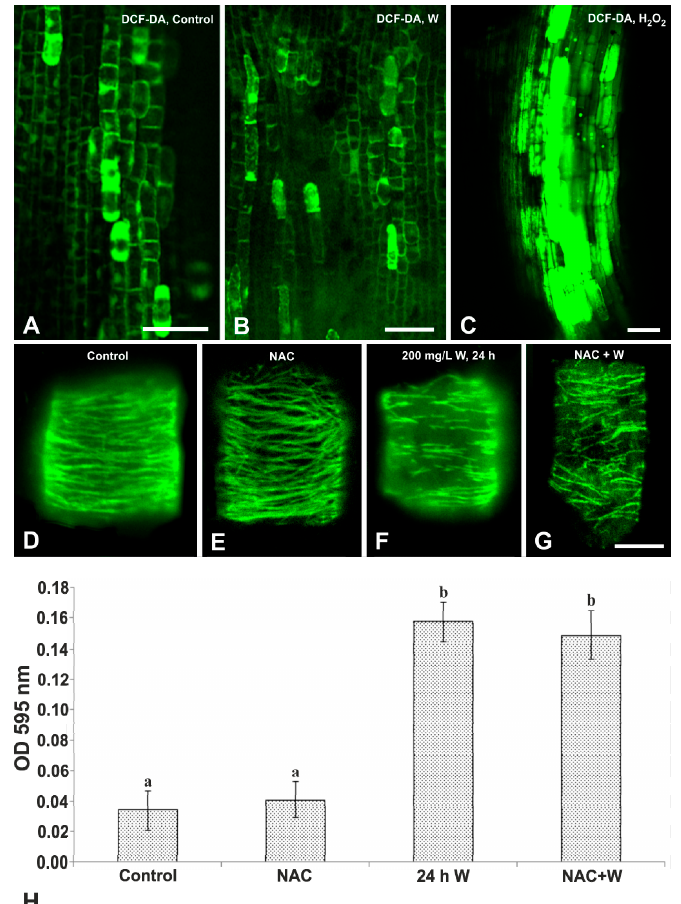
Figure 7. Determination of reactive oxygen species (ROS) production by DCF-DA staining and N-acetylcysteine (NAC) treatment. ( A – C ). Single CLSM paradermal sections in the meristematic zone. Untreated root ( A ), treated with 200 mg/L W, 24 h ( B ) and with H 2 O 2 , 24 h ( C ). Only the positive control seedling ( C ) displayed intense staining of numerous cells. D – G . Projections of CLSM sections. MT immunolocalization in interphase cells of untreated ( D ), NAC-treated ( E ) and W-treated seedlings ( F ) and seedlings treated with a combined treatment with NAC for 24 h and then with NAC+W for 24 h ( G ). The cortical MTs in untreated ( D ) and NAC-treated seedlings ( E ) exhibit a typical organization, while they appear disrupted in W-treated ( F ) and NAC+W-treated ( G ) seedlings. H. Diagram illustrating the optical density (OD) at 595 nm of pea root extracts after NAC+W combination treatments as depicted, Evans blue staining and extraction. The ODs of untreated and NAC-treated extracts are low and similar, while those of W-treated and NAC+W-treated extracts are much higher. Values correspond to means ± SE of three independent experiments. Different letters represent statistically significant differences at p ≤ 0.05. Scale bars: A–C = 100 μ M; D–G = 10 μ M.